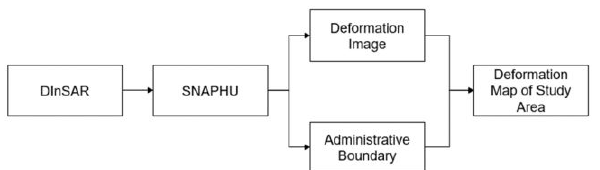
Figure 5. Phase Unwrapping to Map Output